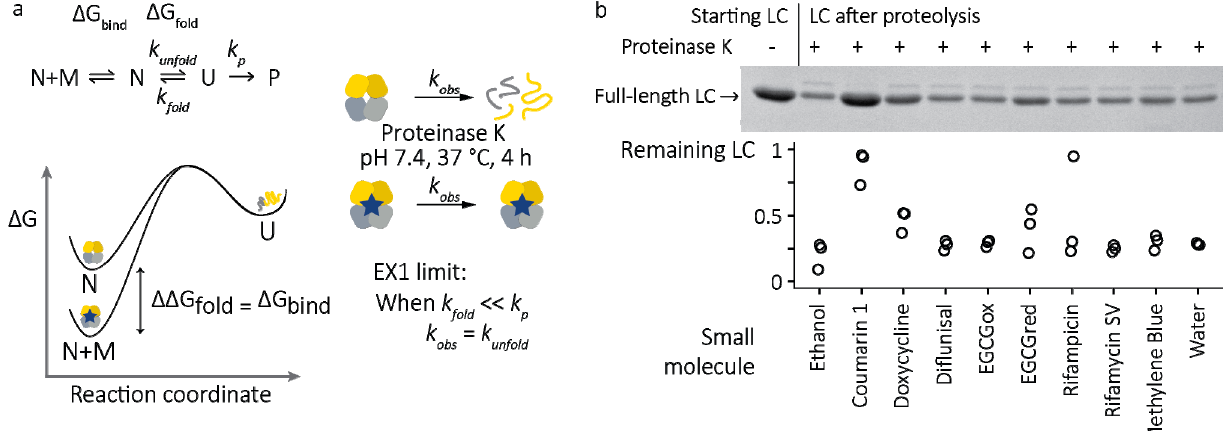
Figure 4. Stabilization of LCs measured by proteolysis. ( a ) Experimental outline. Transient unfolding of native LCs (N) to protease-sensitive conformations (U) limits the rate at which the LCs are cleaved by proteinase K. Binding of small-molecule ligands (M) stabilizes LCs against unfolding and therefore reduces the rate of proteolysis. ( b ) Residual full-length LC after incubation with proteinase K and small molecules was measured by SDS-PAGE ( n = 3 independent reactions per molecule). Top, example gel showing the starting material ( left lane) and remaining LC after incubation ( right lanes). Bottom, quantitation of gel bands, relative to the un-proteolyzed LC.